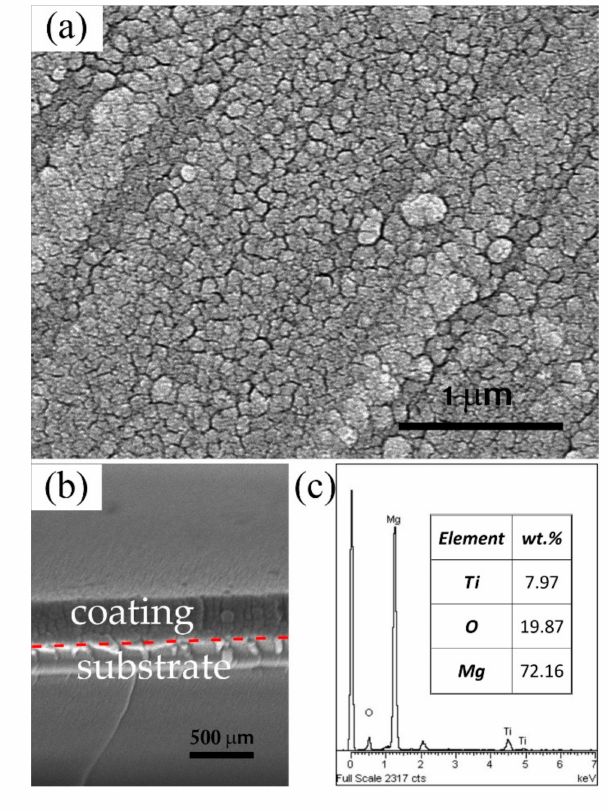
Figure 1. SEM morphologies of ( a ) surface and ( b ) cross-sectional microstructures, and ( c ) the EDS spectra of the titanium oxide-coated MgZn alloy.